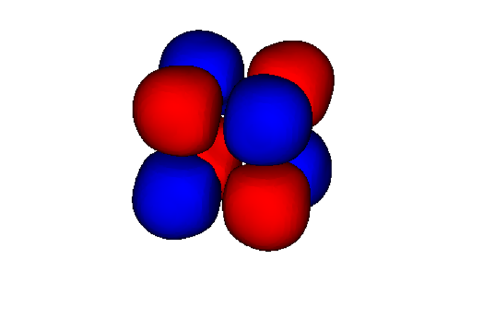
Figure 32. Octupole CSQ in 3+1D.